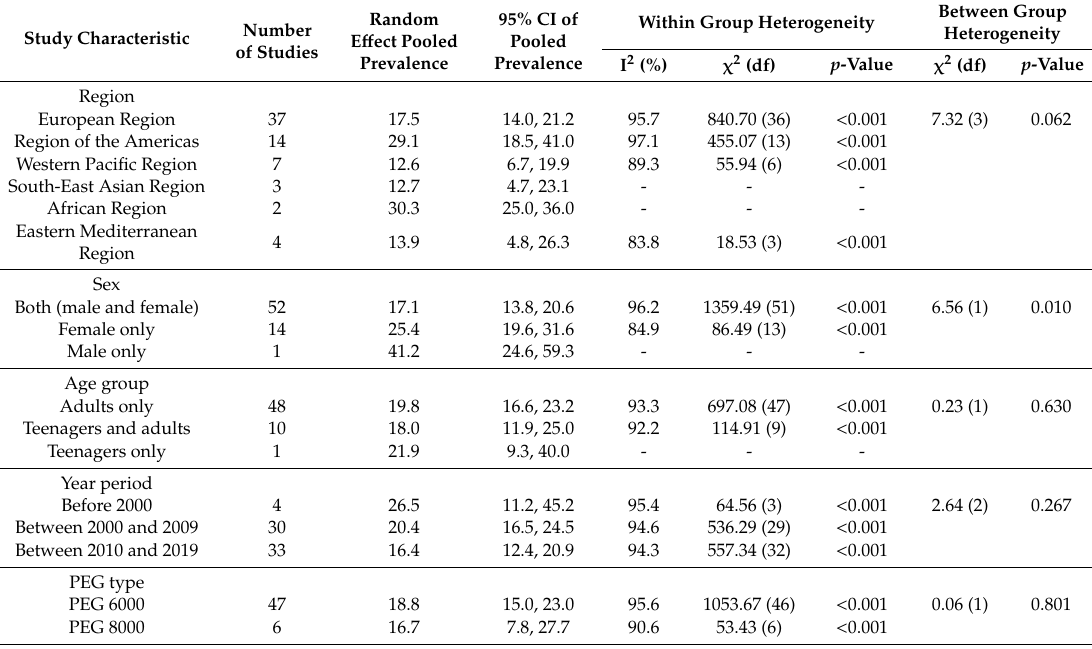
Table2. Subgroupanalysisoftheprevalenceofmacroprolactinemiaamongpatientswithhyperprolactinemia.